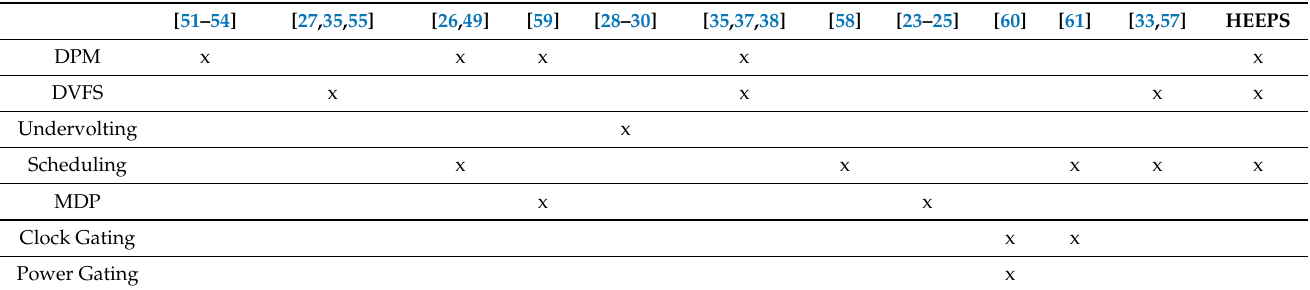
Table 2. Comparison of Energy Saving